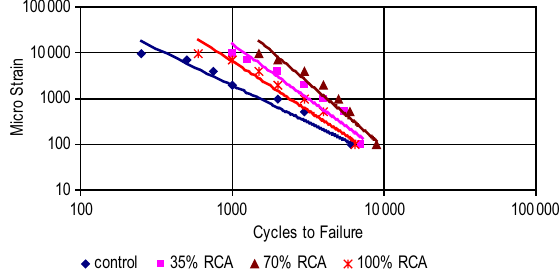
Fig. 7. Comparison of fatigue behavior of different mixes at 40 °C for gradation type